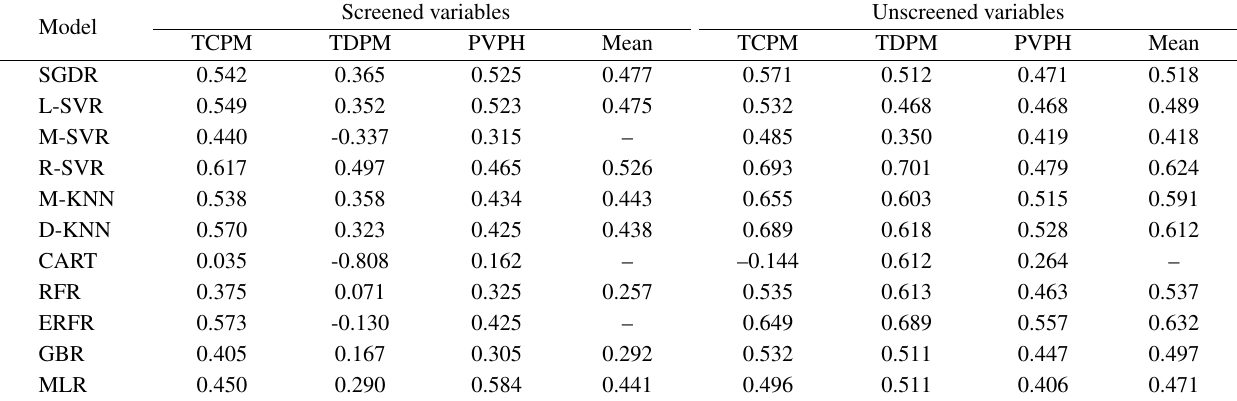
Table 1 Regression model coefficient of determination R 2 and its mean